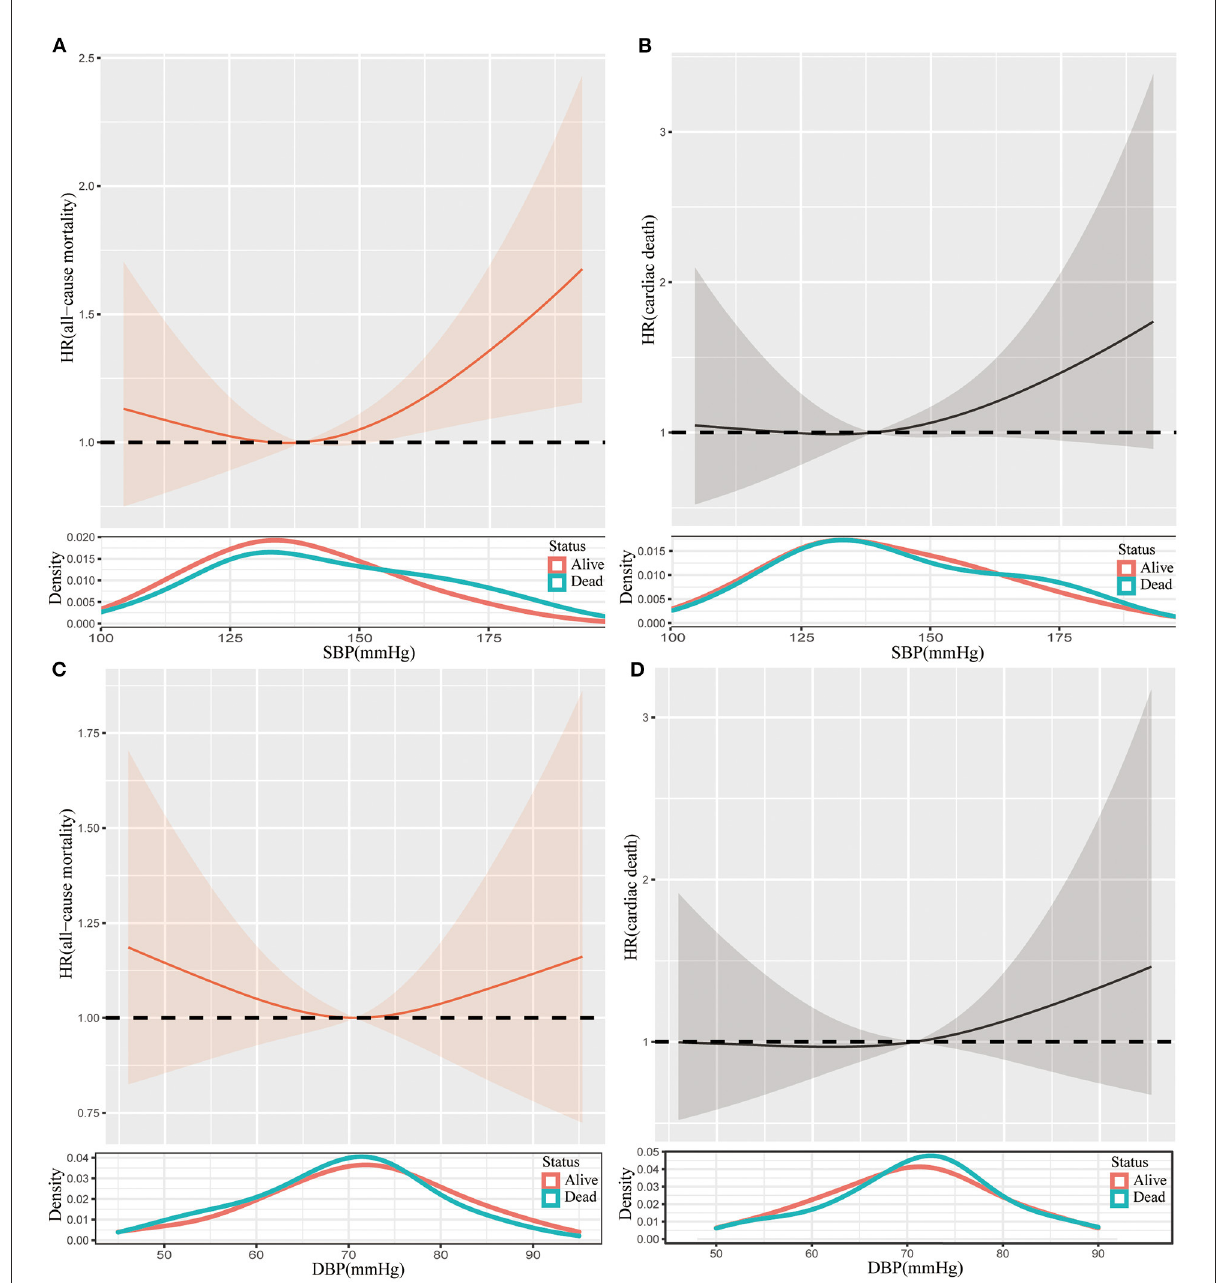
FIGURE3 Restricted cubic spline plots of the association between SBP and all-cause mortality (A) , SBP and cardiac death (B) , DBP and all-cause mortality (C) , and DBP and cardiac death (D) in prefrail participants. Analysis was adjusted for age, gender, race, diabetes, stroke, coronary artery disease, smoker, antihypertensive medication. SBP, systolic blood pressure; DBP, diastolic blood pressure; HR, hazard